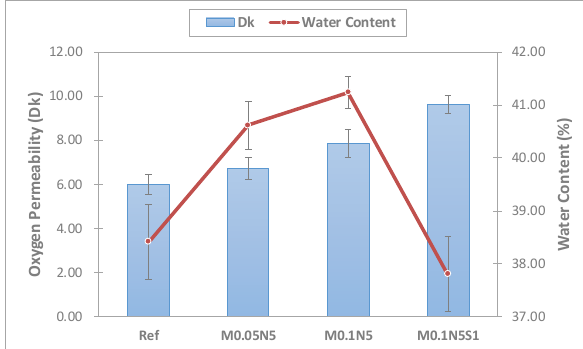
Figure 4. Oxygen permeability and water content of samples.